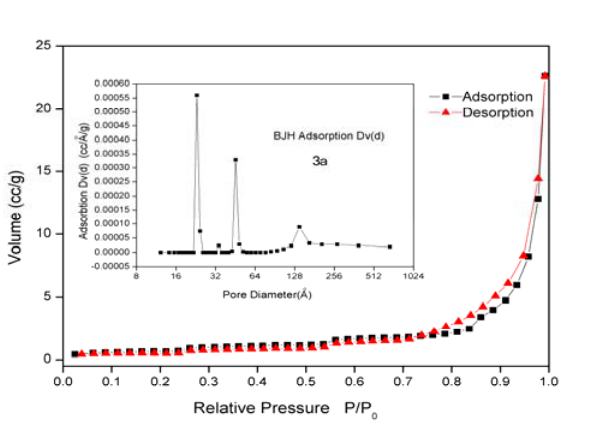
Figure 5. The nitrogen adsorption-desorption isotherms of